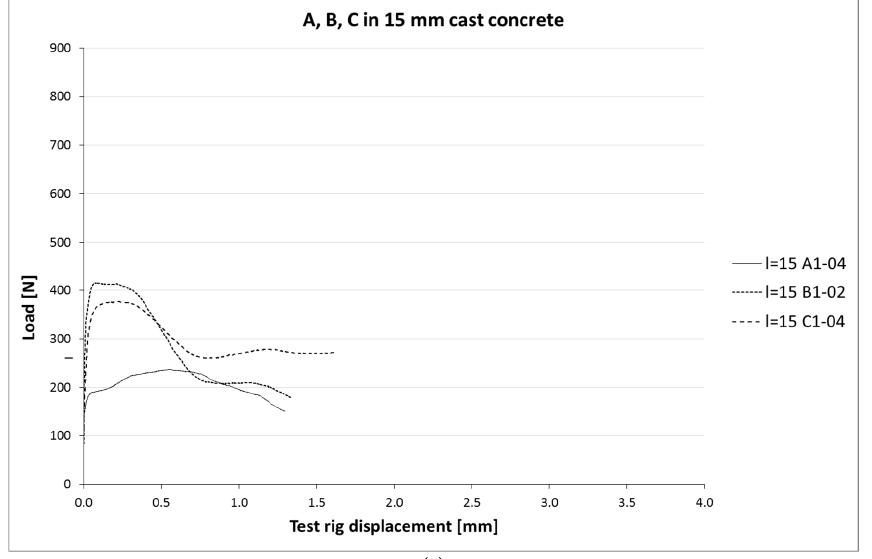
Figure 5. Test set-up for the cast ( a , b ) and printed ( c , d ) specimens.